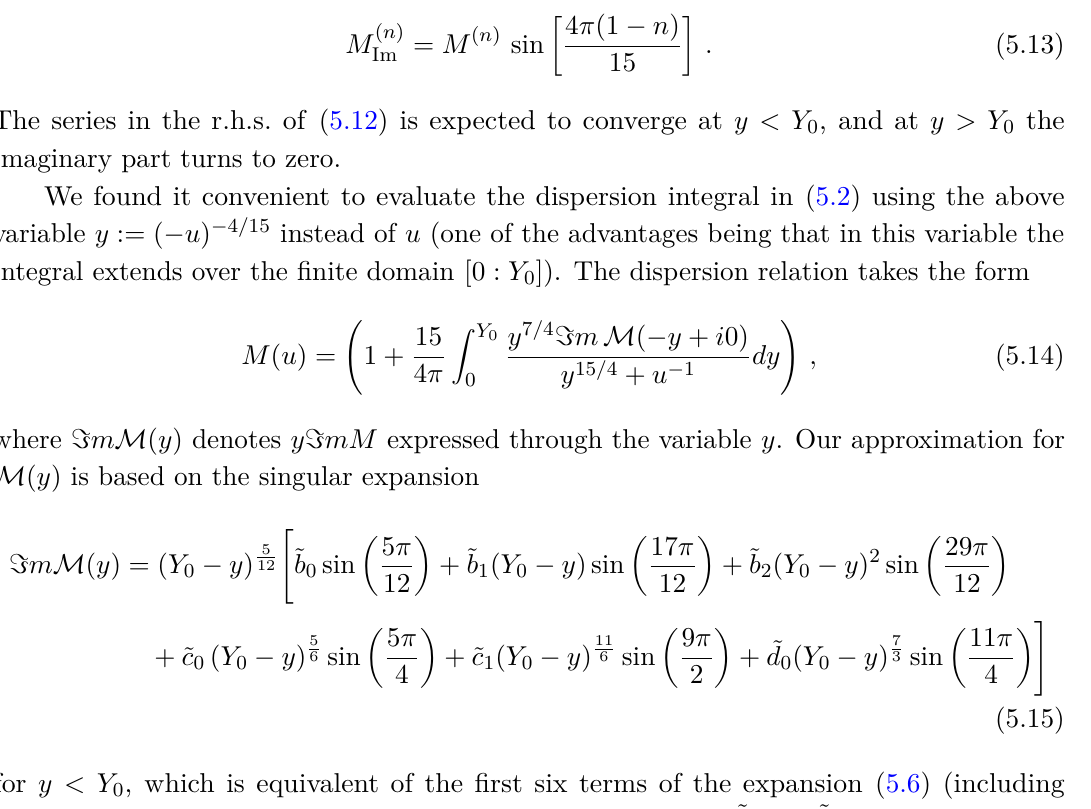
Table 2 . Numerical values of the 6-parameter singular expansion coefficients, see eq. (5.15). where again y = ( − u ) − 4 / 15 ,